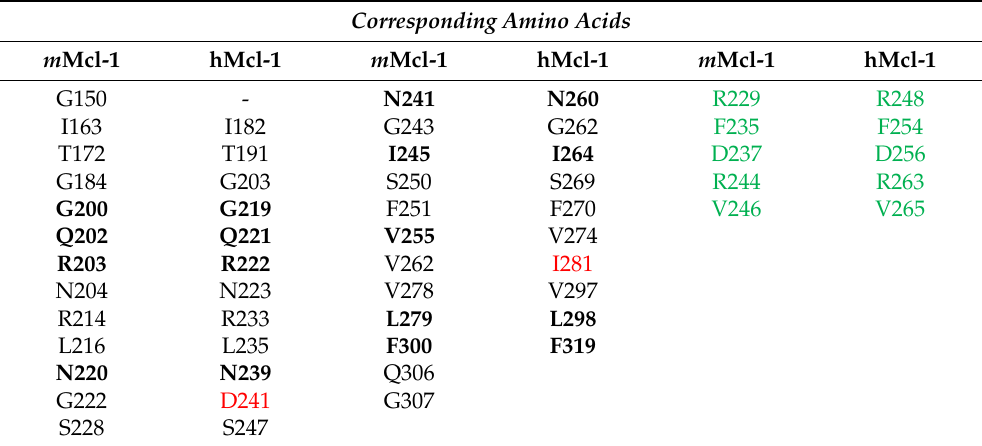
Table 6. Comparison between m Mcl-1 and hMcl-1 active site residues *. Corresponding Amino